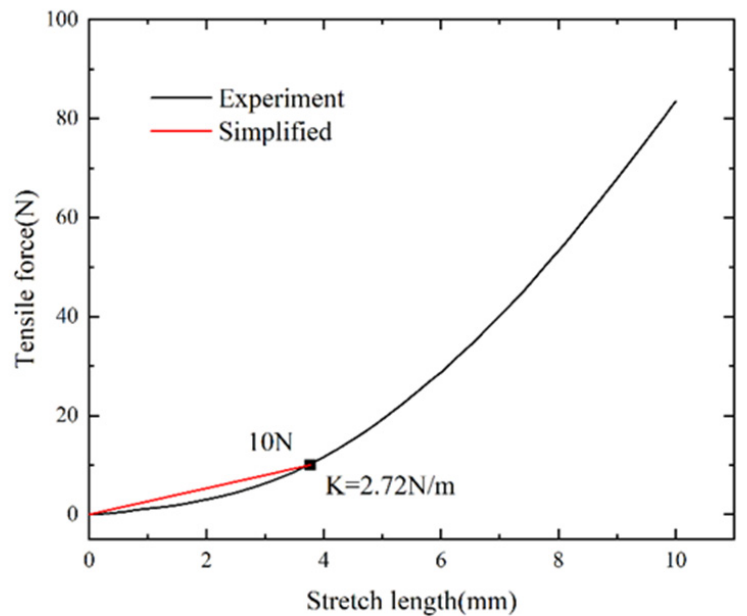
Figure 6. Tensile stiffness test of suspension